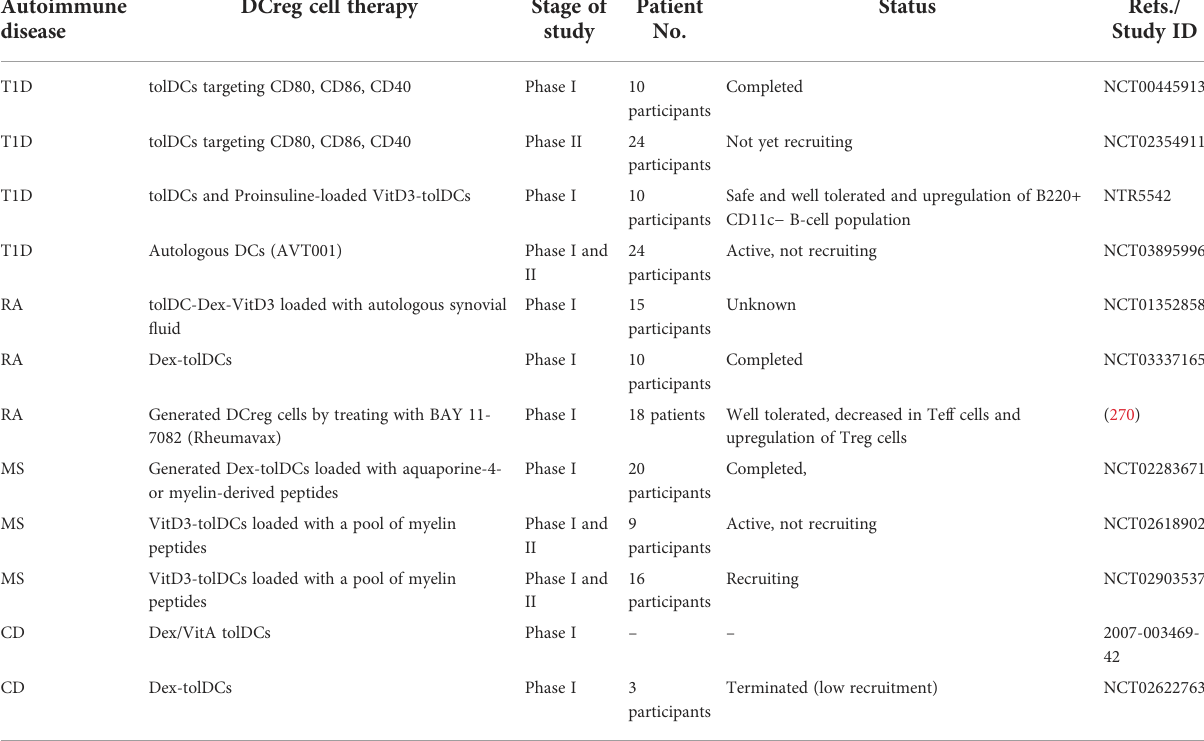
TABLE 3 Clinical trials using DCs in autoimmune disease therapy. Autoimmune